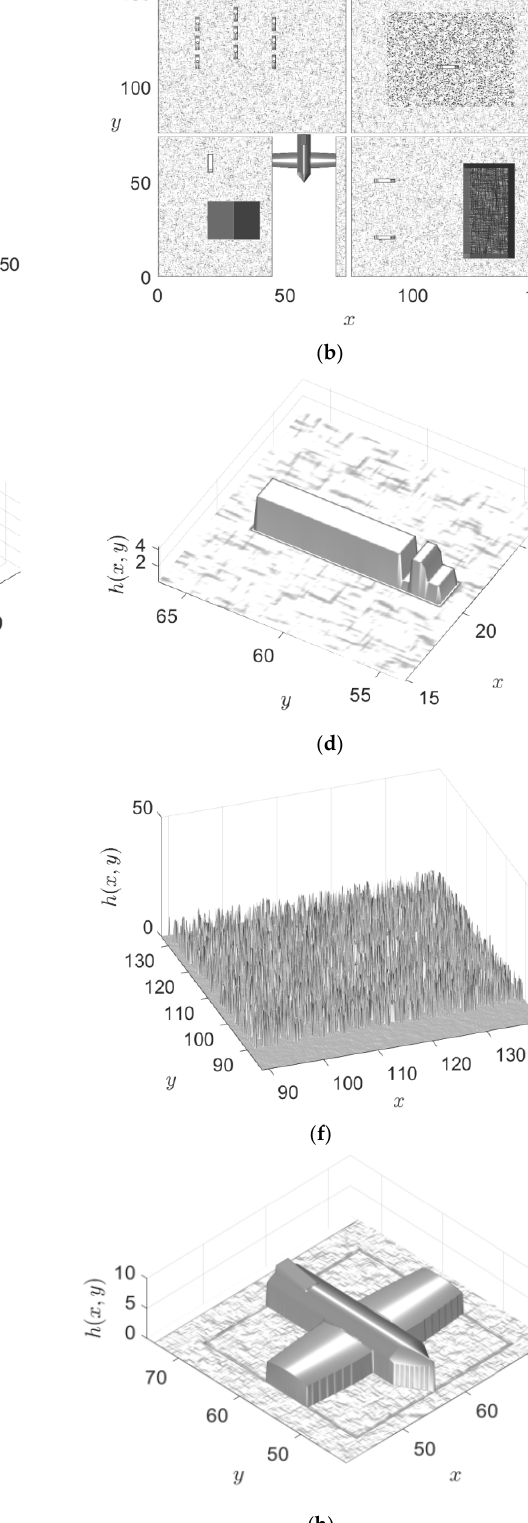
Figure 3. Altitude profile of the simulation model: ( a ) the model of the entire observation area, ( b ) the top projection, ( c ) the model of the building, ( d ) the model of the tractor with trailer, ( e ) the model of tanks, ( f ) the model of the forest, ( g ) the model of anti-aircraft missile system, ( h ) the model